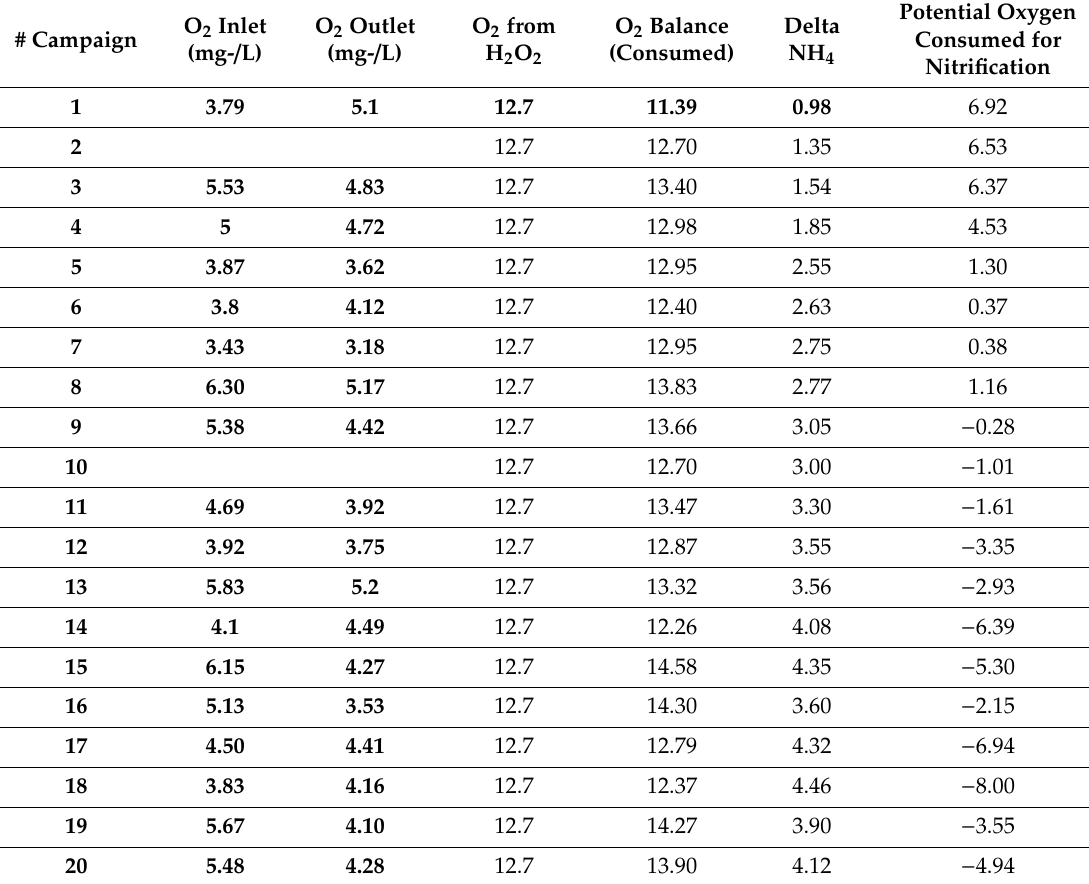
Table A2. Oxygen mass Balance of the biofilter system with and without H 2 O 2